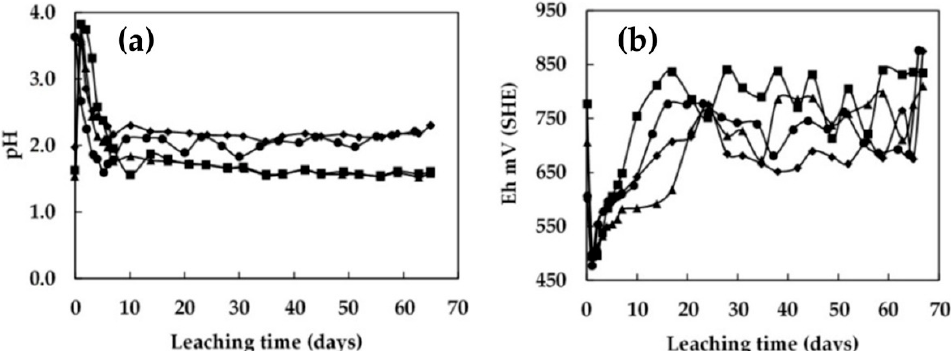
Figure 10. Bioleaching of chalcopyrite ore at ambient temperature with continuous irrigation with different raffinate solutions. ▲ 3.0 g/L of acid, 1.0 g/L total iron, and 107 cells/mL; ■ 3.0 g/L of acid, different raffinate solutions. (cid:78) 3.0 g/L of acid, 1.0 g/L total iron, and 107 cells/mL; (cid:4) 3.0 g/L of 1.0 g/L total iron, and 5.0 × 10 7 cells/mL; ♦ pH-controlled at 2.0, 1.0 g/L of total iron, and 5.0 × 10 7 acid, 1.0 g/L total iron, and 5.0 × 10 7 cells/mL; (cid:7) pH-controlled at 2.0, 1.0 g/L of total iron, and cells/mL; ● pH-controlled at 1.5, 1.0 g/L of total iron, and 5.0 × 10 7 cells/mL. ( a ) Variation of pH and 5.0 × 10 7 cells/mL; • pH-controlled at 1.5, 1.0 g/L of total iron, and 5.0 × 10 7 cells/mL. ( a ) ( b ) variation in redox potential.